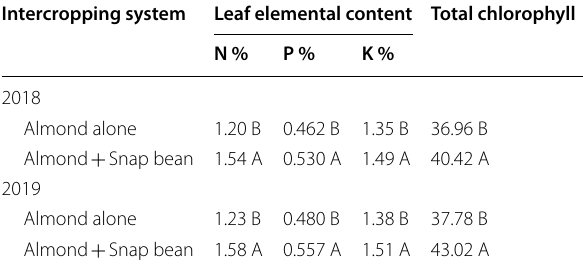
Values with diferent letter across the same row are signifcantly diferent ( p < 0.05)